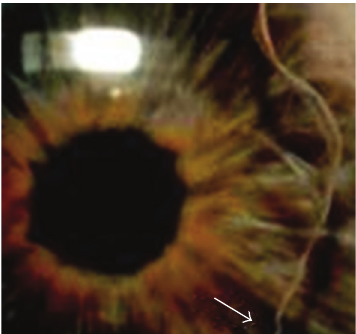
Figure 2: Embryotoxon posterius ( ↑ ) and hypoplasia of the iris in patient